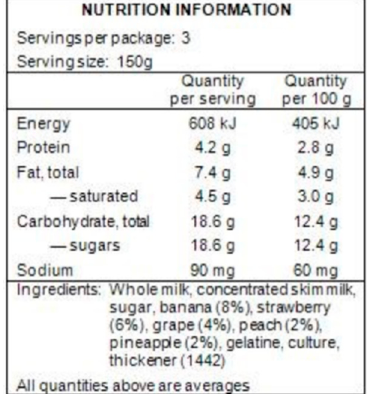
Figure A1. Nutrition Information Panel (Australia) provides information on the average amount of energy (in kilojoules or both in kilojoules and kilocalories), protein, fat, saturated fat, carbohydrate, sugars and sodium in the food, as well as any other claim that requires nutrition information. The nutrition information must be presented in a standard format which shows the average amount per serve and per 100 g (or 100 mL, if liquid) of the food.